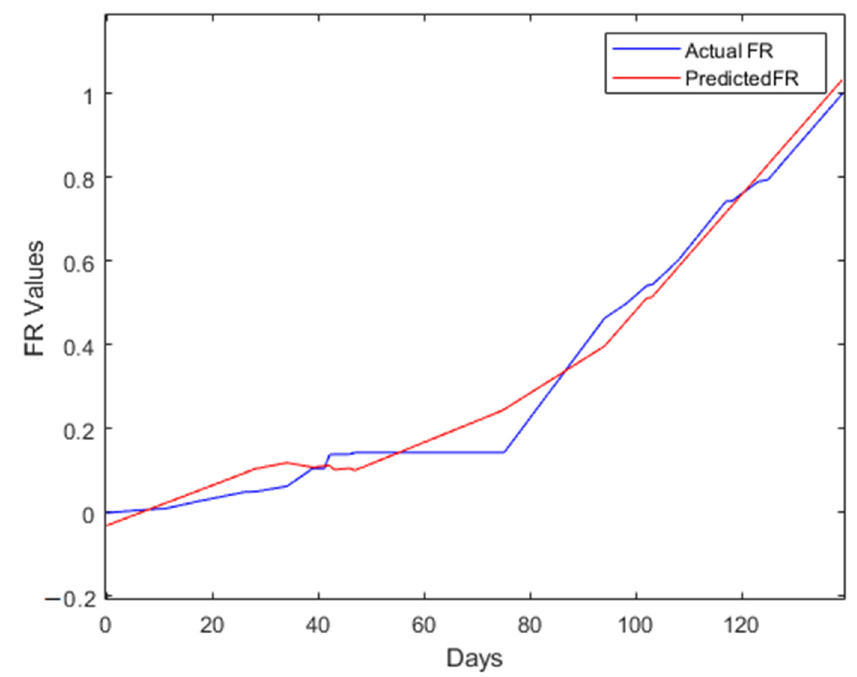
Figure 5. Graph of actual and regression normalized FR values (kaolin).